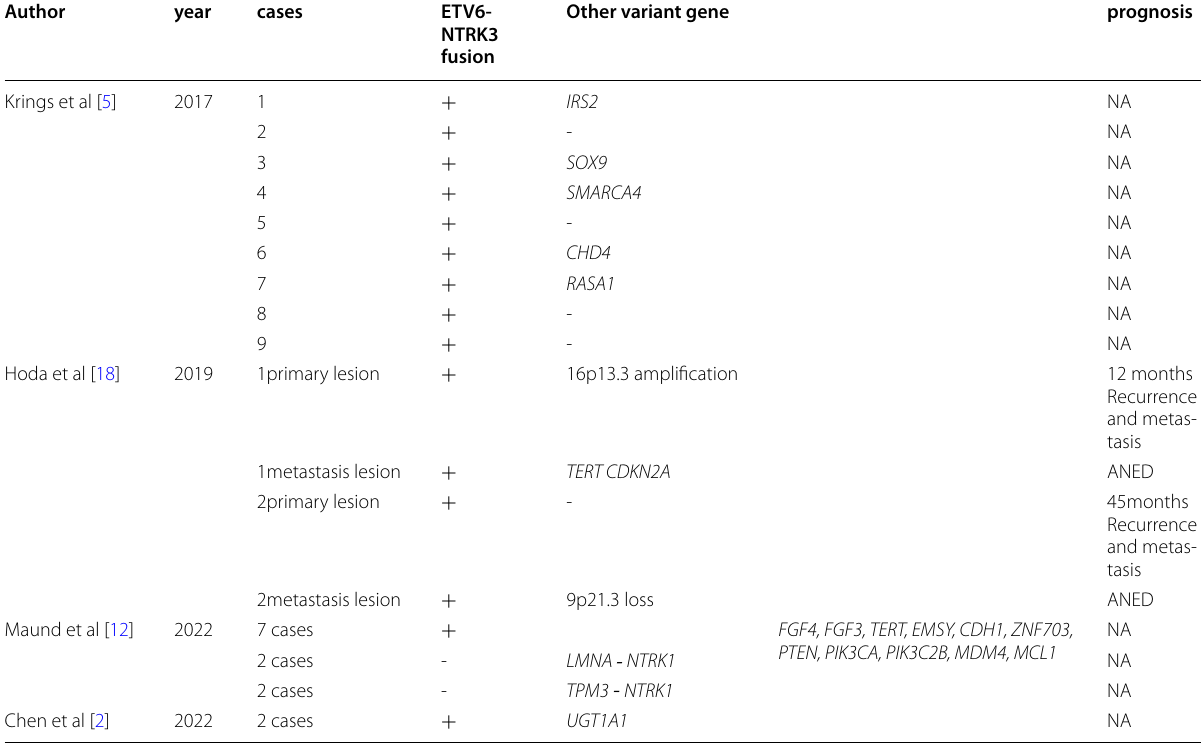
NA Not available, ANED alive with no evidence of